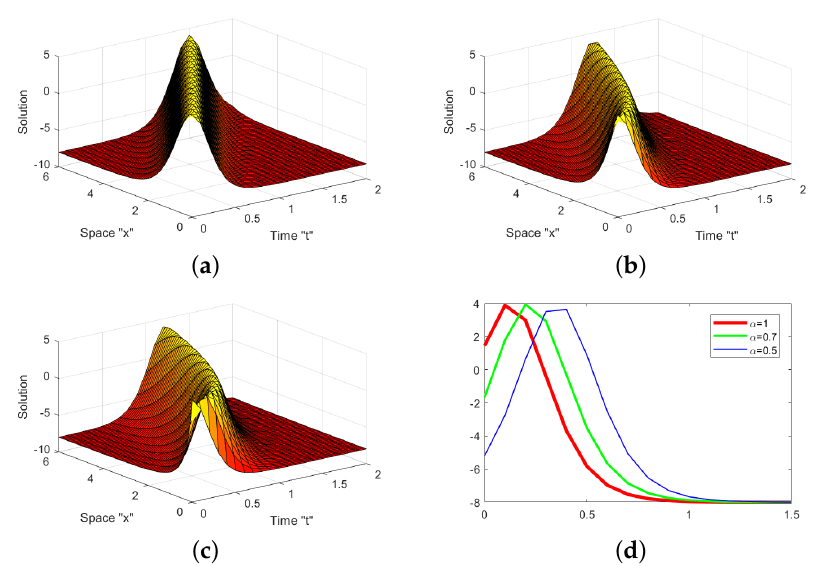
√ 13 indicate the 3D profiles